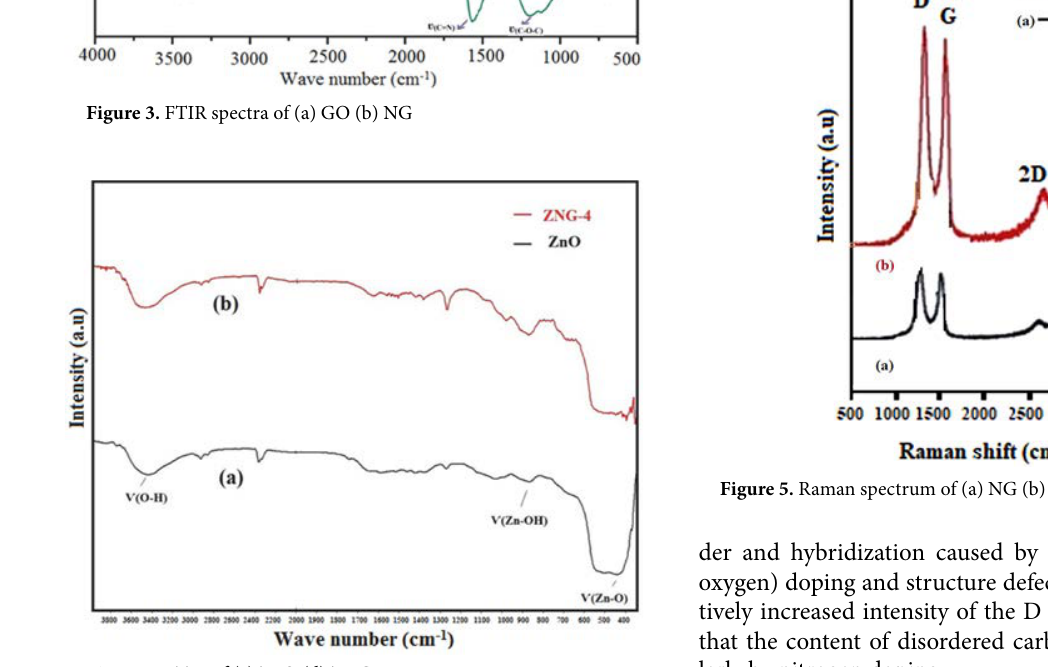
Figure 4. FTIR of (c) ZnO (d) ZNG-4.